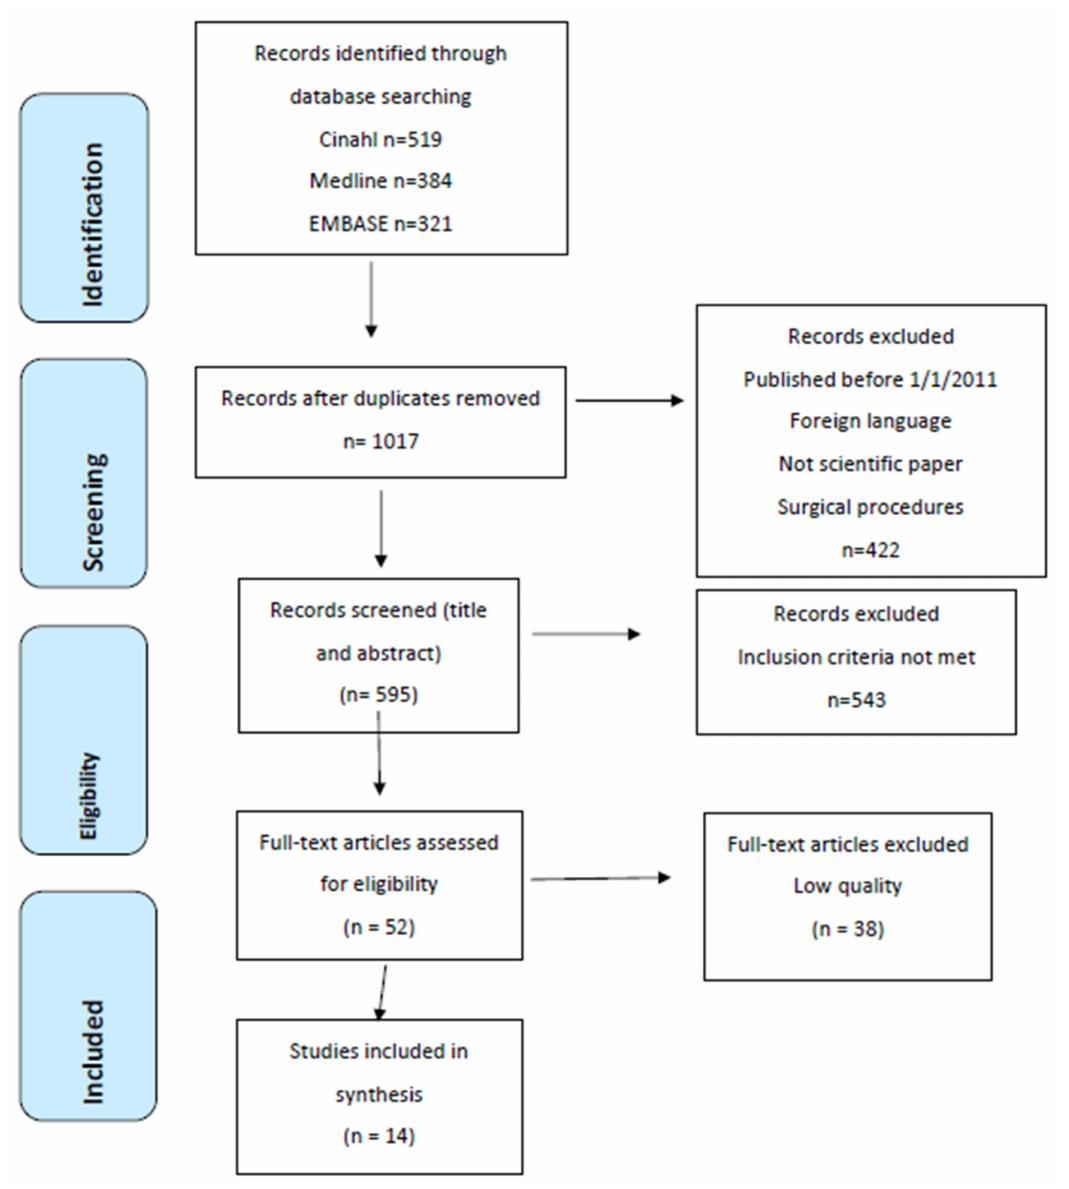
Figure 1. PRISMA 2009 Flow